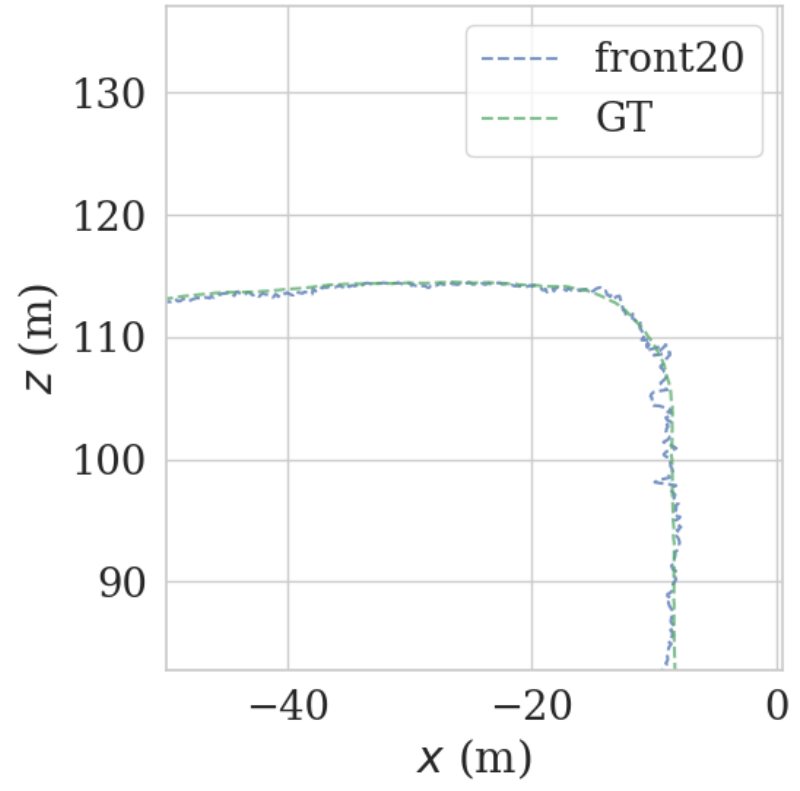
Figure 13. Track error using front LiDAR data at curves.